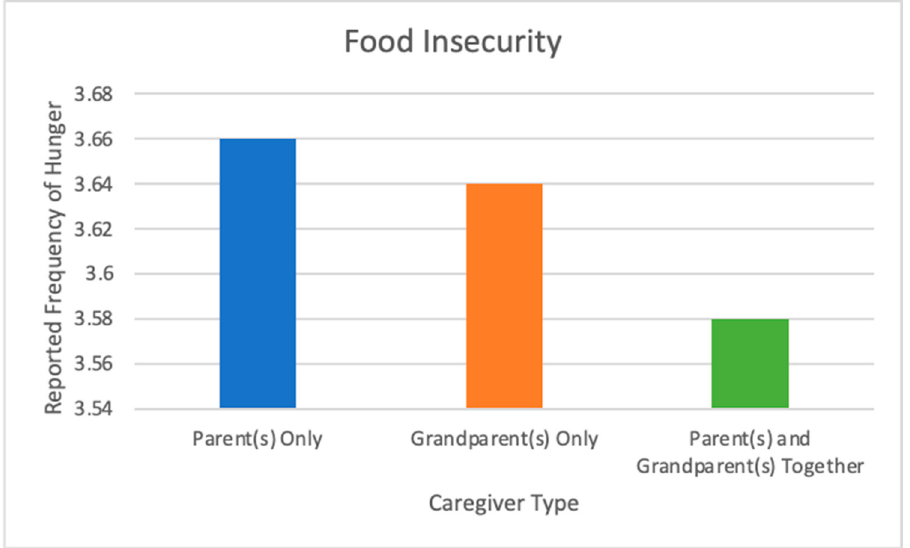
Figure 2. Adolescents’ reported frequency of hunger grouped by type of primary caregiver, controlling for socioeconomic status. Responses were measured regarding how often they went to school or bed feeling hungry because there was no food at home, where 1 was “always” and 4 was “never”. Higher bars indicate more food security and going hungry less often. Adolescents in multi-generational households were significantly more likely to report going hungry more